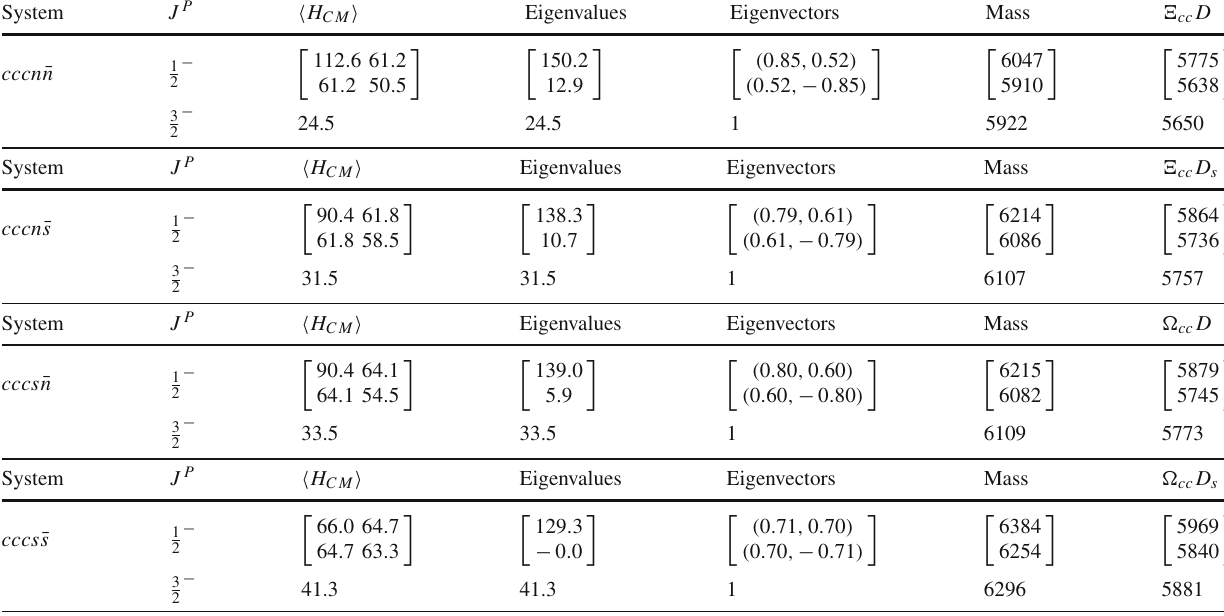
Table 5 Numerical results for the cccq ¯ q systems in units of MeV. The masses in the sixth column are estimated with Eq. (18) and those in the last column with the ( ccq ) - ( c ¯ q ) type threshold System